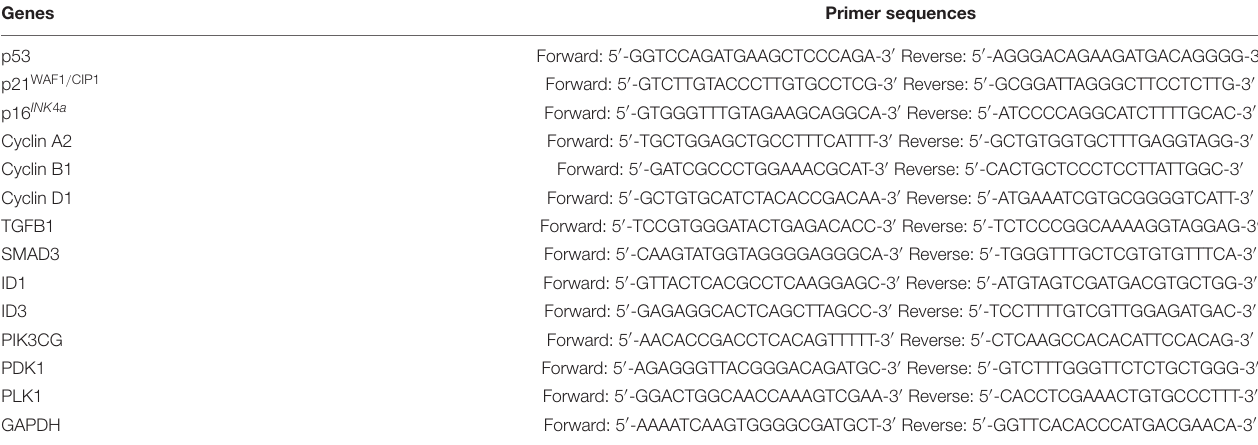
TABLE 1 | Primer sequences for RT-PCR analysis. Genes Primer